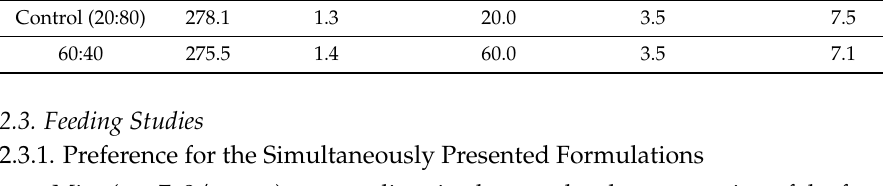
Table 1. Nutritional composition of prepared milk formulations per 100 mL. kJ Protein (g) Whey Protein (%) Fat